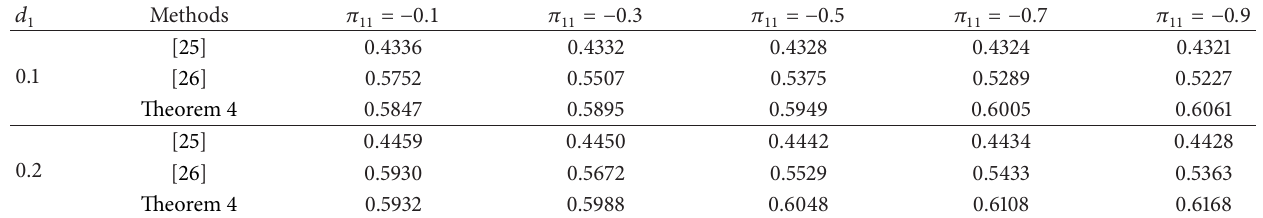
Table 2: Admissible upper bounds 𝑑 2 with varying 𝜋 11 and 𝑑 1 .